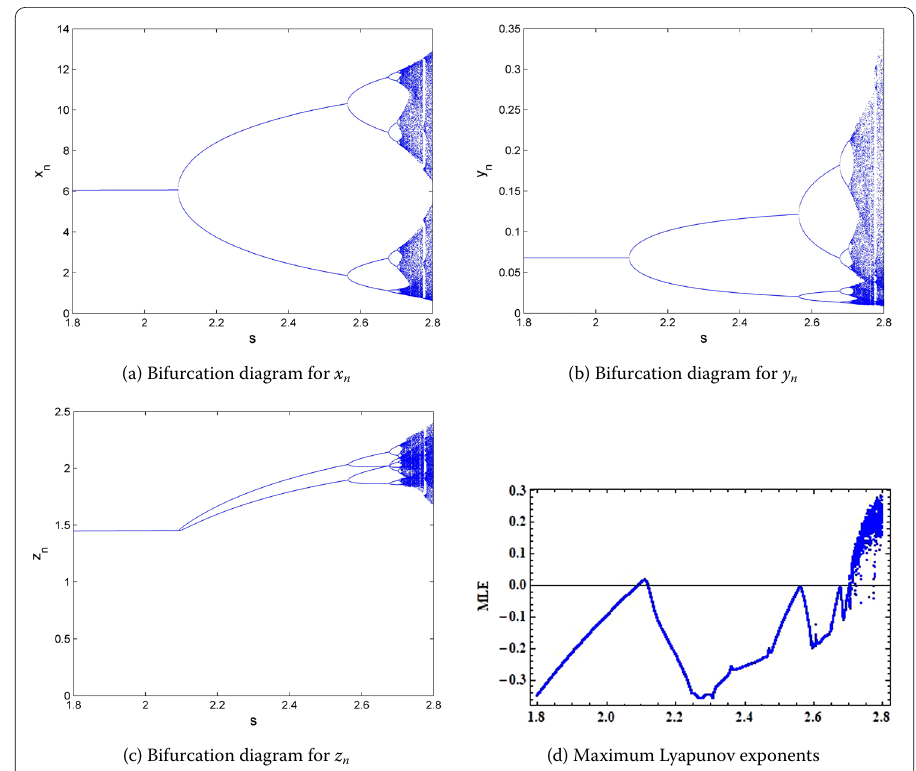
Figure 1 Bifurcation diagrams and MLE for system (1.3) with α = 0.5, k = 6.2, β = 0.9, δ = 0.85, μ = 0.5, γ = 1.5, η = 0.1, c = 8.5, s ∈ [1.8,2.8] and initial conditions ( x 0 , y 0 , z 0 ) =